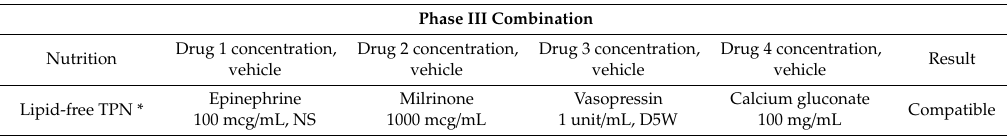
Table 5. Phase III overall physical compatibility